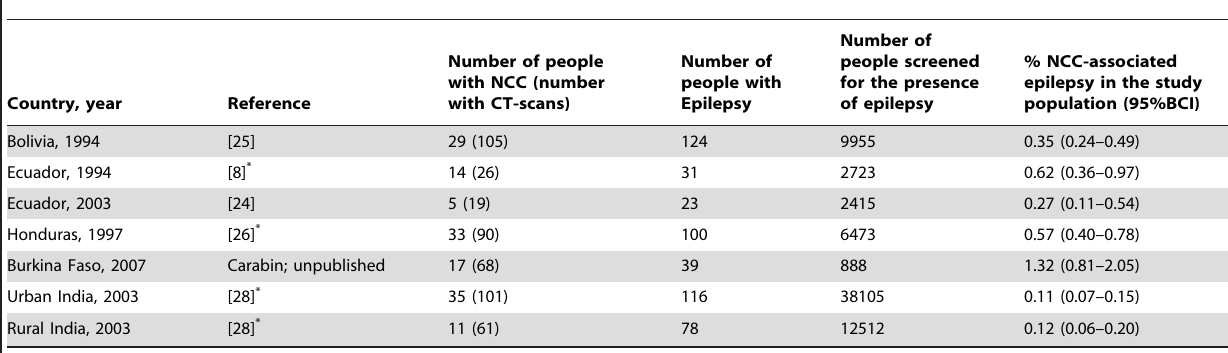
Table 4. Prevalence (%) of NCC-associated epilepsy and 95% Bayesian Credible Interval (95% BCI) in community-based studies.